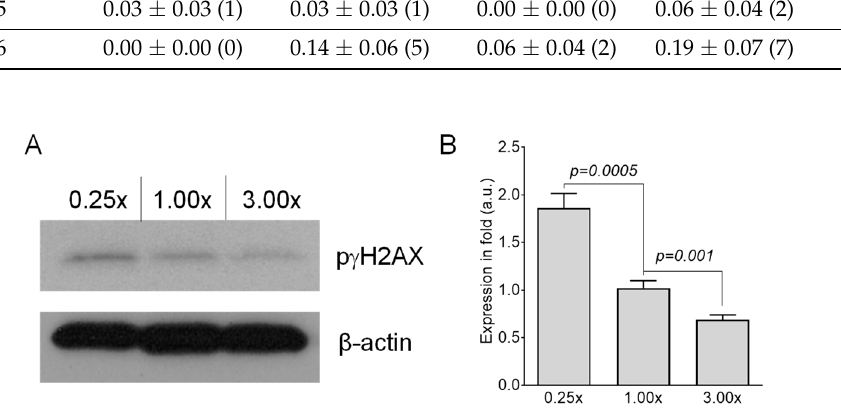
Table 1. Distribution of aberration frequencies ± standard errors (number of aberrations observed) detected by G-banding after 1-month culture of RAW 264.7 cells in either methionine-adequate media (1.00 × ) or methionine-deficient media (0.05 × ). RT, Robertsonian translocation; CSB, chromosomal breaks; a, statistically significant difference in total yield from 1.00 × media.